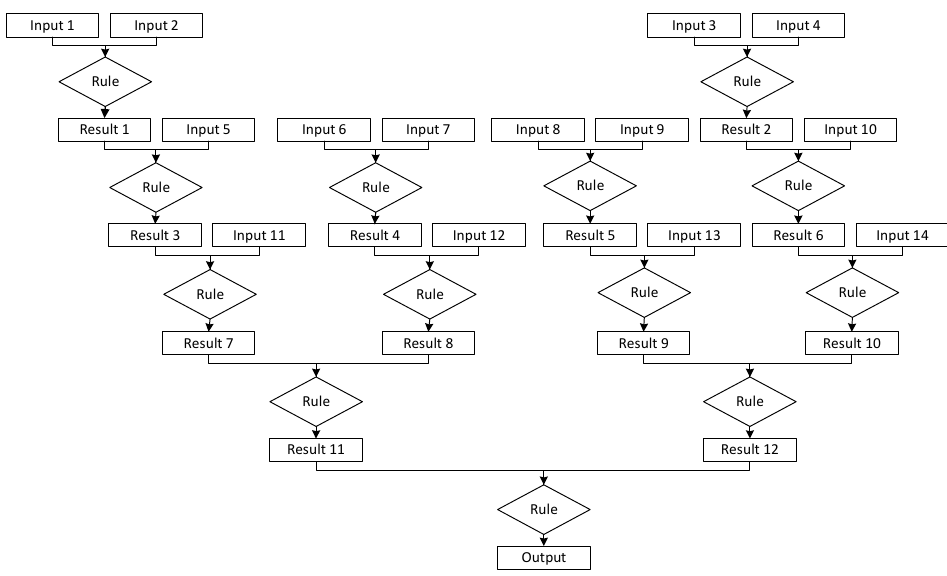
Figure 4. Logical design of Network 4.